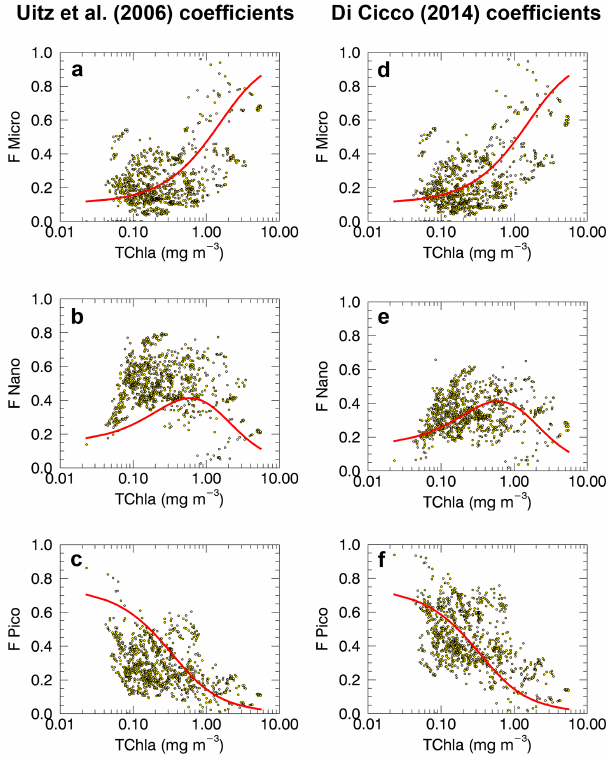
Figure 2. BR model (red line) plotted against in situ PSC classifica- tion (yellow dots) obtained using the Uitz et al. (2006) coefficients ( a–c , on the left panel) and Di Cicco (2014) coefficients ( d–f , on the right panel). The yellow dots refer to the in situ size class frac- tions resulting from the use of the diagnostic pigments (DP) of the SeaBASS Mediterranean